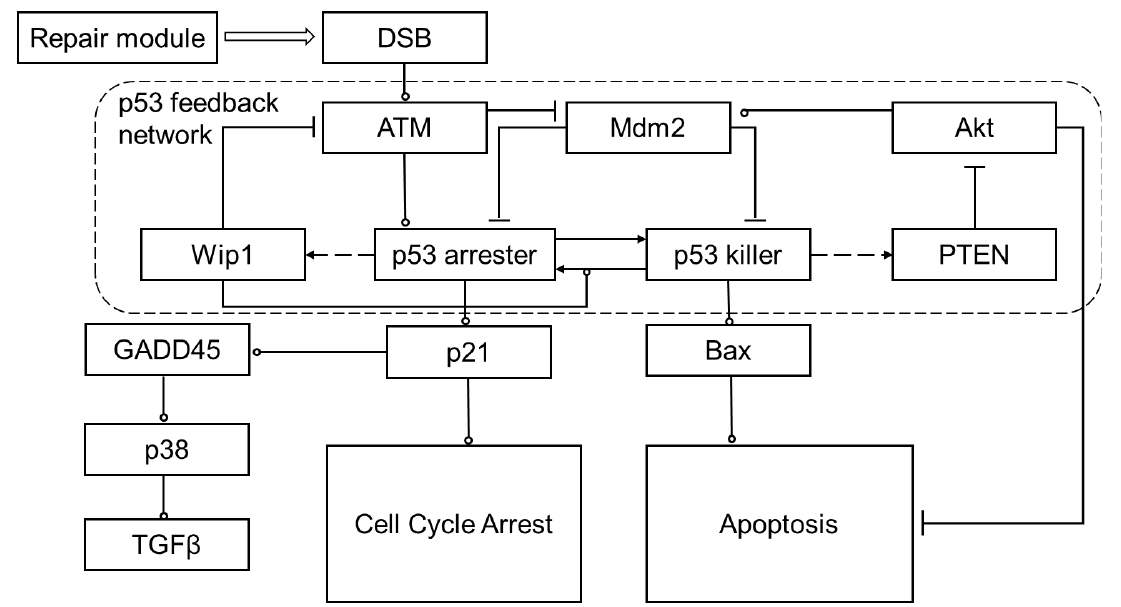
Figure 10. Scheme of the p53 system and related modules of cell cycle arrest apoptosis and TGFβ secreting. Arrow-headed dashed lines indicate positive transcriptional regulation, arrow-headed solid lines — protein transformation, circle-headed solid lines — positive influence or activation, hammer-headed solid lines — inhibitory regulation. The description of the proteins, genes, and RNAs are listed in the Supplementary Materials, Table S1.